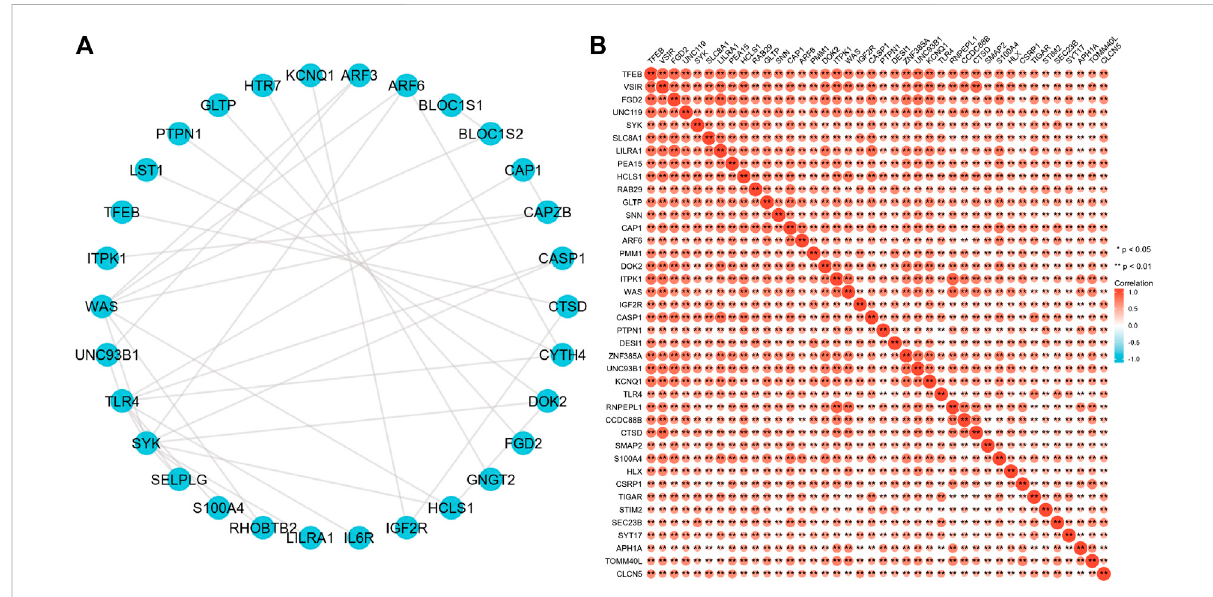
FIGURE 7 B4GALT1-associated gene interaction network (A) and gene co-expression matrix (B)